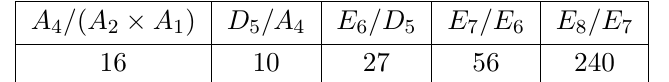
Table 5 . The number of cosets of two Weyl groups #